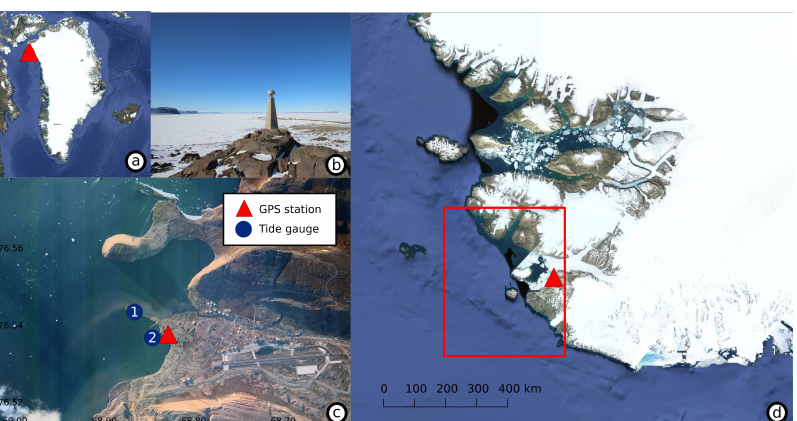
Figure 2. Maps illustrating the study area. ( a ) Map of Greenland. Thule is marked by the red triangle. ( b ) Picture of the GNSS station in Thule with the view over the ocean. ( c ) Map of Thule with GNSS- and TG station locations. 1 marks the position of the TG until September 2015 and 2 marks the position since then. ( d ) The red rectangle illustrates the area used for sea level extraction from